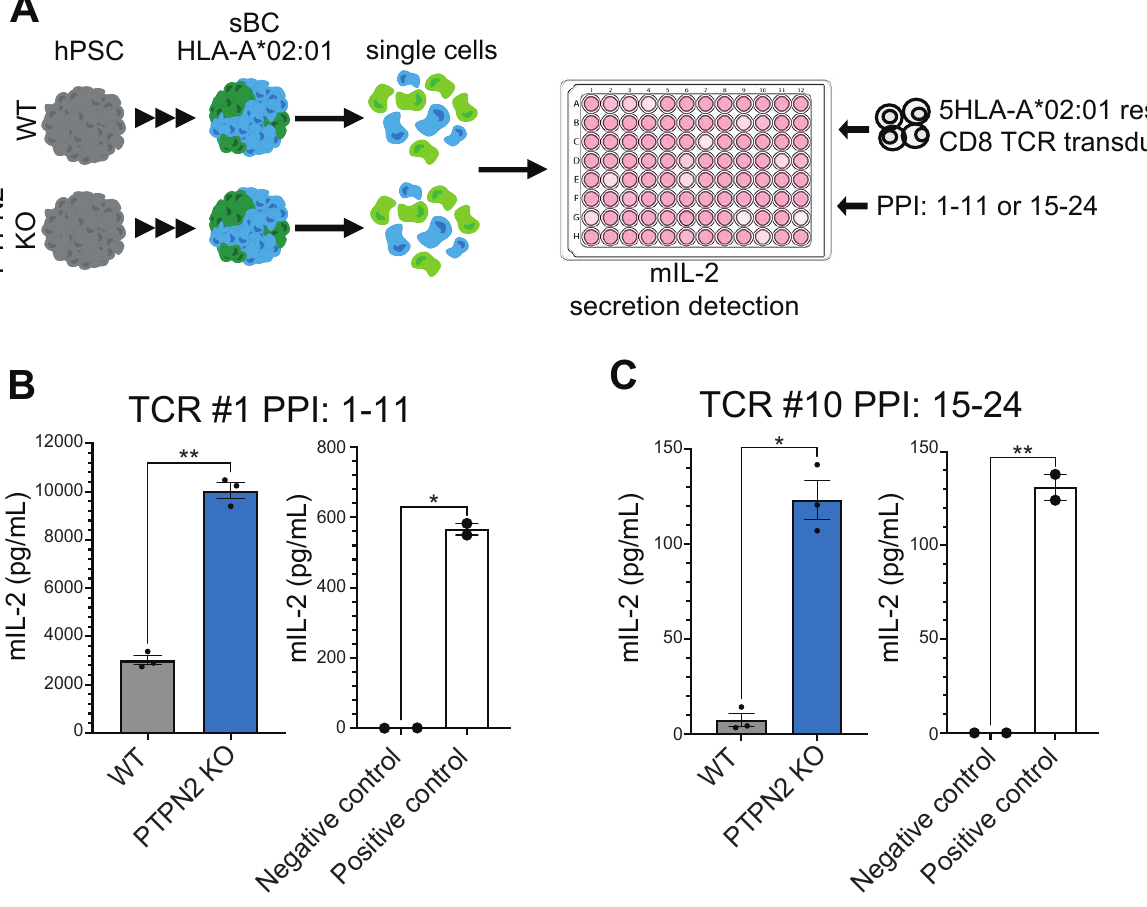
Figure 4. Activated autoreactive T-cell transductants produce increased levels of IL-2 when stimulated by PTPN2 KO sBCs. ( A ) Schematic depicting the sBC and CD8 T cell receptor transductant (5KC-1.E6 or 5KC-1.C8) co-culture experiment. ( B , C ) Representative stimulation assay (of 3 technical repeats) of WT (gray) and PTPN2 KO (blue) sBC co-cultured with 5KC-1.C8 (TCR #1 PPI: 1-11) ( n = 1) ( B )